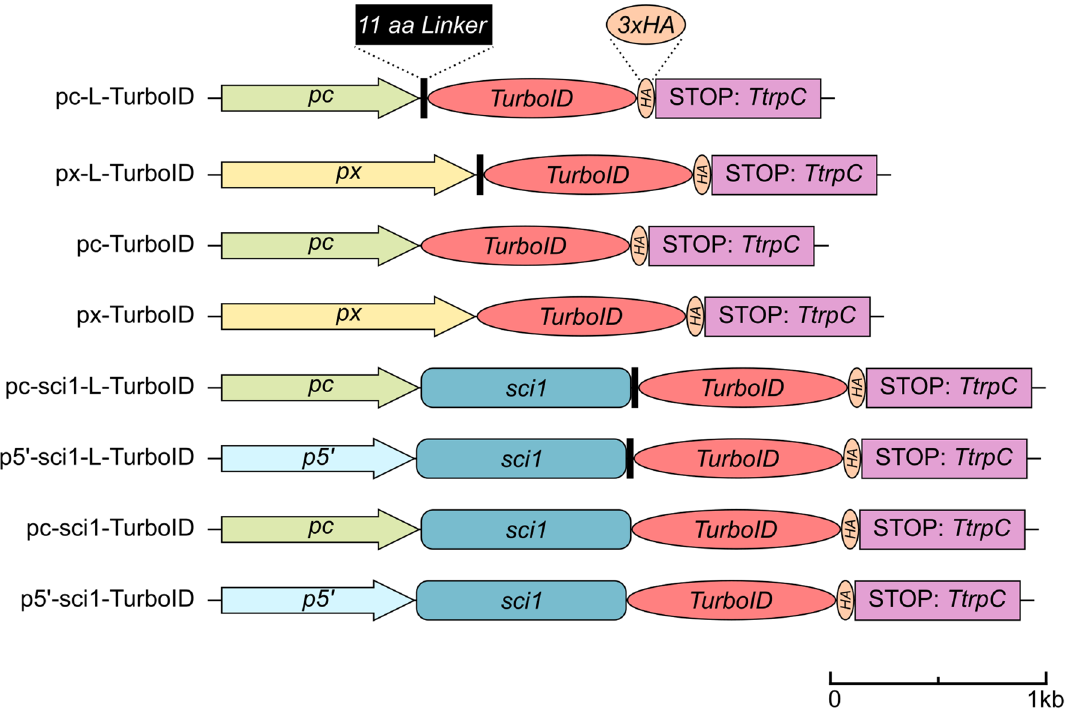
Figure 1. Schematic illustration of constructs used in BioID experiments. For BioID experiments, multiple constructs for the SCI1-TurboID fusion protein and the unfused TurboID control have been generated. The TurboID sequence was codon-optimized according to the codon usage table of S. macrospora 18 . Expression is controlled by different promoters: p5’ , native sci1 promoter; pc , promoter of the clock-controlled gene 1 ( ccg1 ) from N. crassa for overexpression ; px , xylose inducible promoter ( Smxyl ) of the beta-xylanase gene ( SMAC_08023 ) from S. macrospora 19 ; L, 11 amino acid linker (MGGGGSGGGGS) attached to N-terminus of TurboID; TtrpC , terminator of the anthranilate synthase gene from A. nidulans ; a scalebar is indicated.